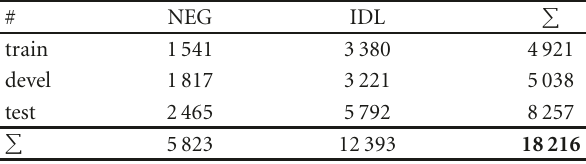
Table 1: Number of instances in the FAU Aibo Emotion Corpus. The partitioning corresponds to the INTERSPEECH 2009 Emotion Challenge, with the training set split into a training and develop- ment set